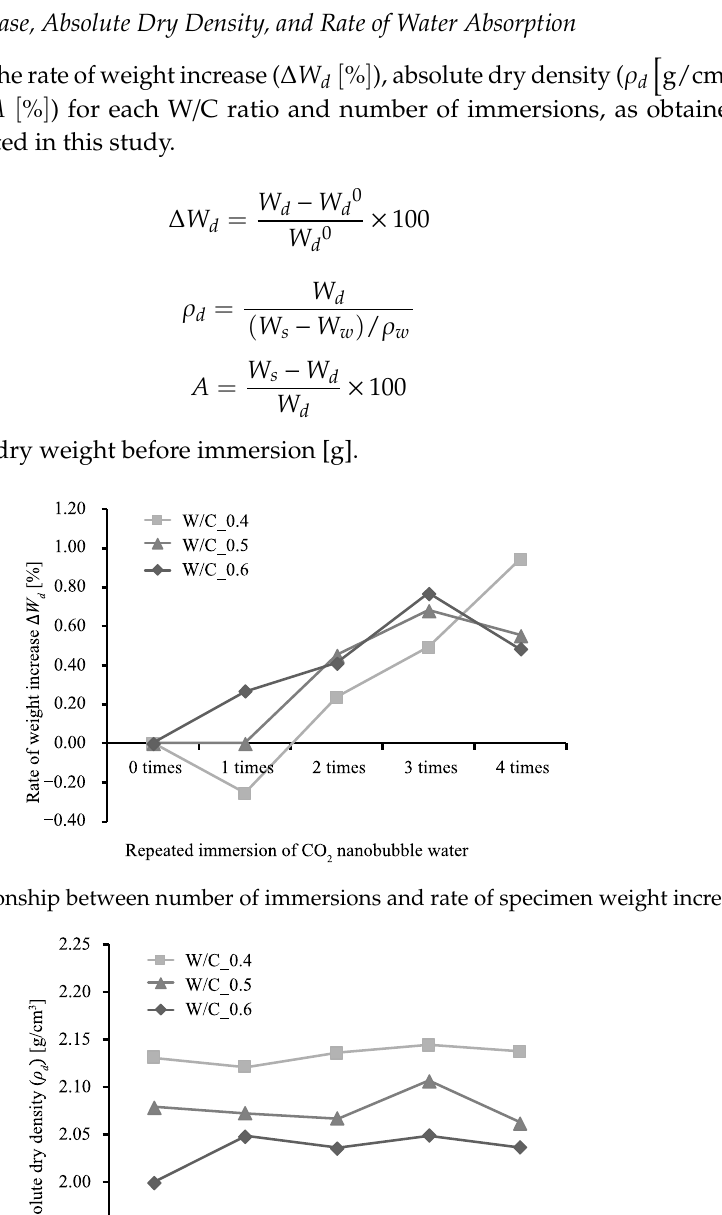
Figure 4. Relationship between number of immersions and rate of water absorption. Figure 5. Relationship between absolute dry density and rate of water absorption. 3.2. Pore Filling Effect of CO 2 Nanobubble Water The porosity 𝑃 (cid:4670)%(cid:4671) and the porosity reduction rate ∆𝑃 (cid:4670)%(cid:4671) , an index representing the reduction in minimum porosity with repeated immersion, defined relative to the porosity of a test specimen that has not been impregnated with CO 2 nanobubble water can be respectively obtained using the measured water absorption results as follows: 𝑃 (cid:3404) (cid:4666)𝑊 (cid:3046) (cid:3398) 𝑊 (cid:3031) (cid:4667) (cid:3403) 𝜌 (cid:3050) (cid:4666)𝑊 (cid:3046) (cid:3398) 𝑊 (cid:3050) (cid:4667) (cid:3403) 𝜌 (cid:3050) (cid:3400) 100